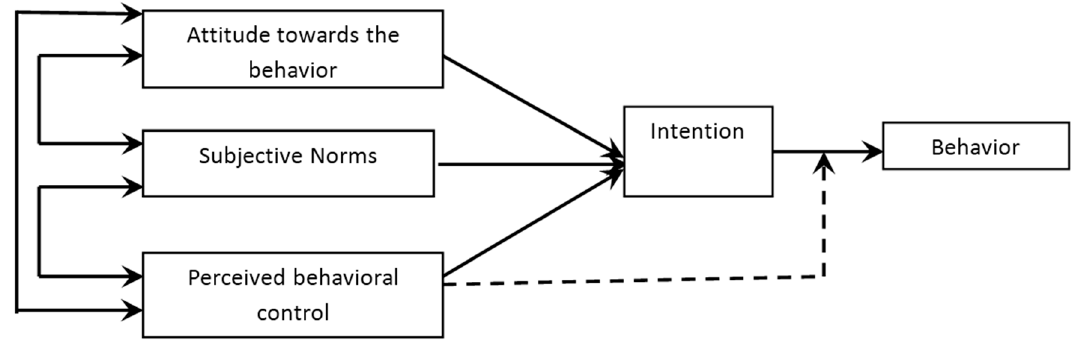
Figure 1. Standard Theory of planned behavior constructs [37].